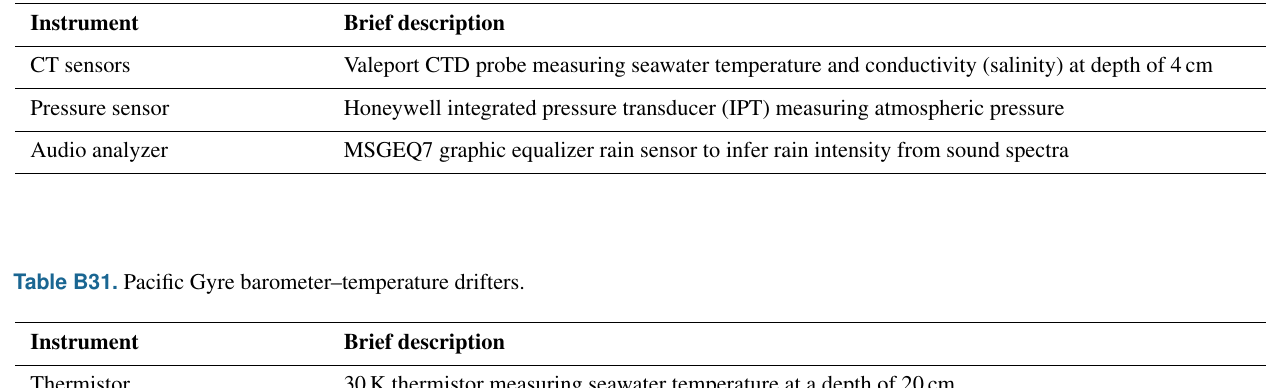
Table B30. SURPACT drifters.